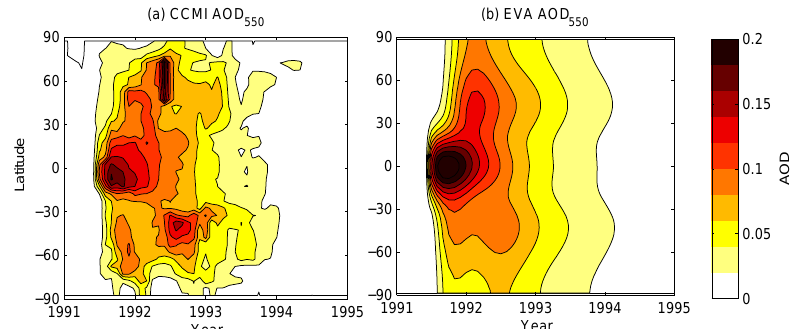
Figure 3. Aerosol optical depth ( λ = 550nm) evolution after Pinatubo from (left) the CCMI database and (right) emulated by EVA.